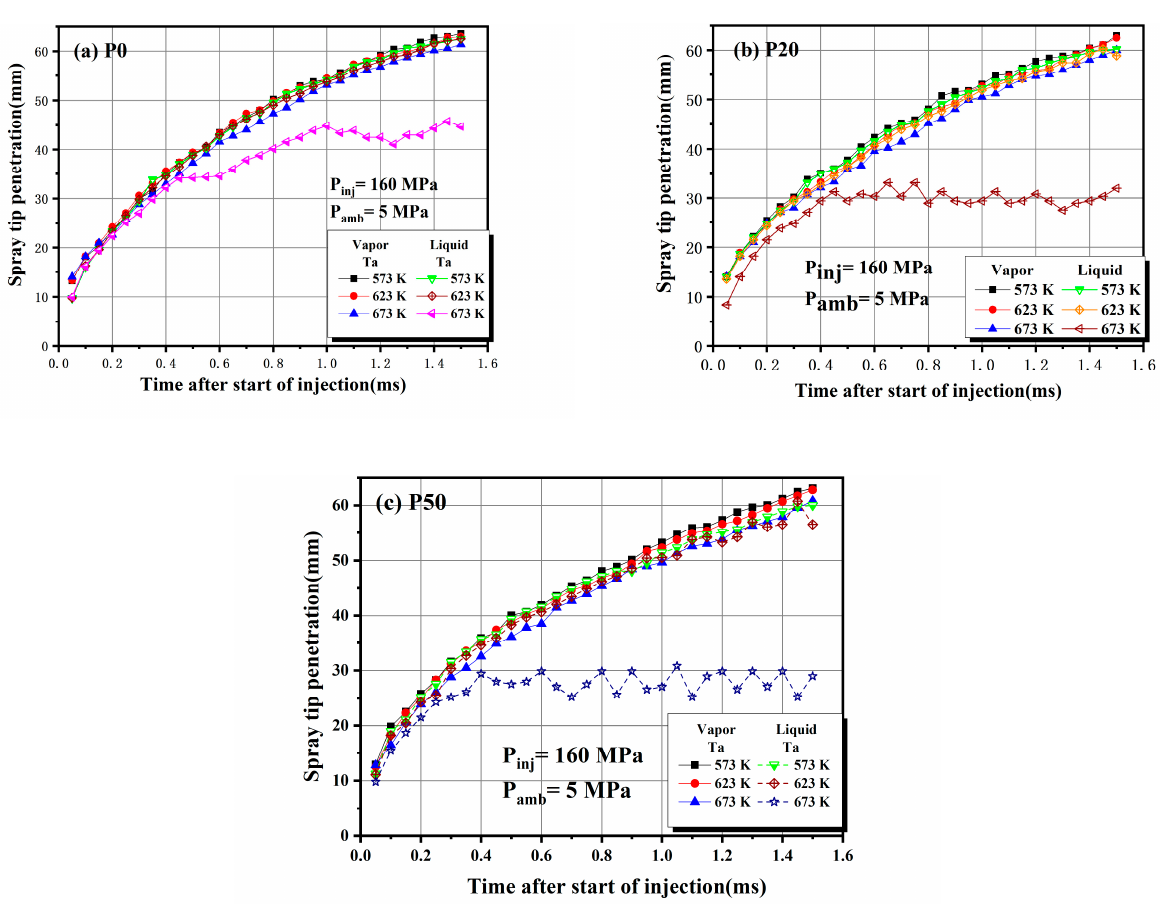
Figure 7. Penetration distances of blends at different temperatures: ( a ) P0, ( b ) P20, ( c ) P50.